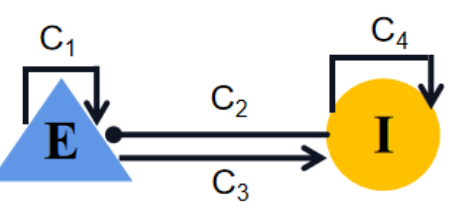
Figure 14. Schematic diagram of the Wilson–Cowan model. E and I are the excitatory and inhibitory neural populations, respectively. C i ( i = 1,2,3,4 ) represent the coupling strengths between and within the subpopulations. Excitatory projections are denoted by arrows, while lines with filled circle represent inhibitory